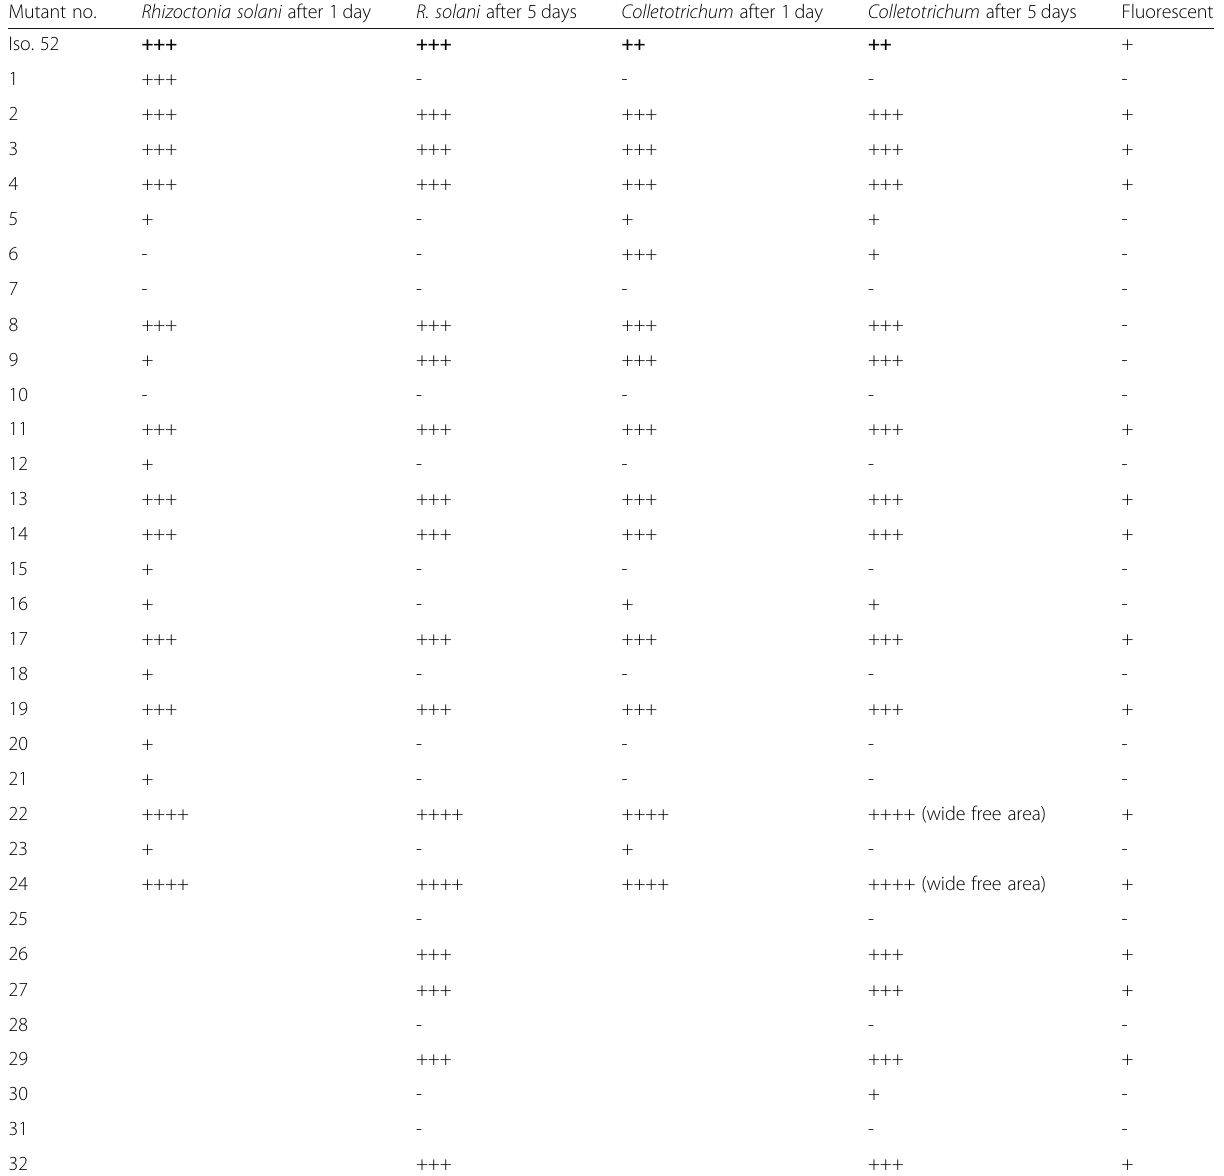
Table 4 Reaction of mutants of bacterial isolate no. 52 ( Pseudomonas fluorescens ) tested for their antagonism to Rhizoctonia solani and Colletotrichum sp. Mutant